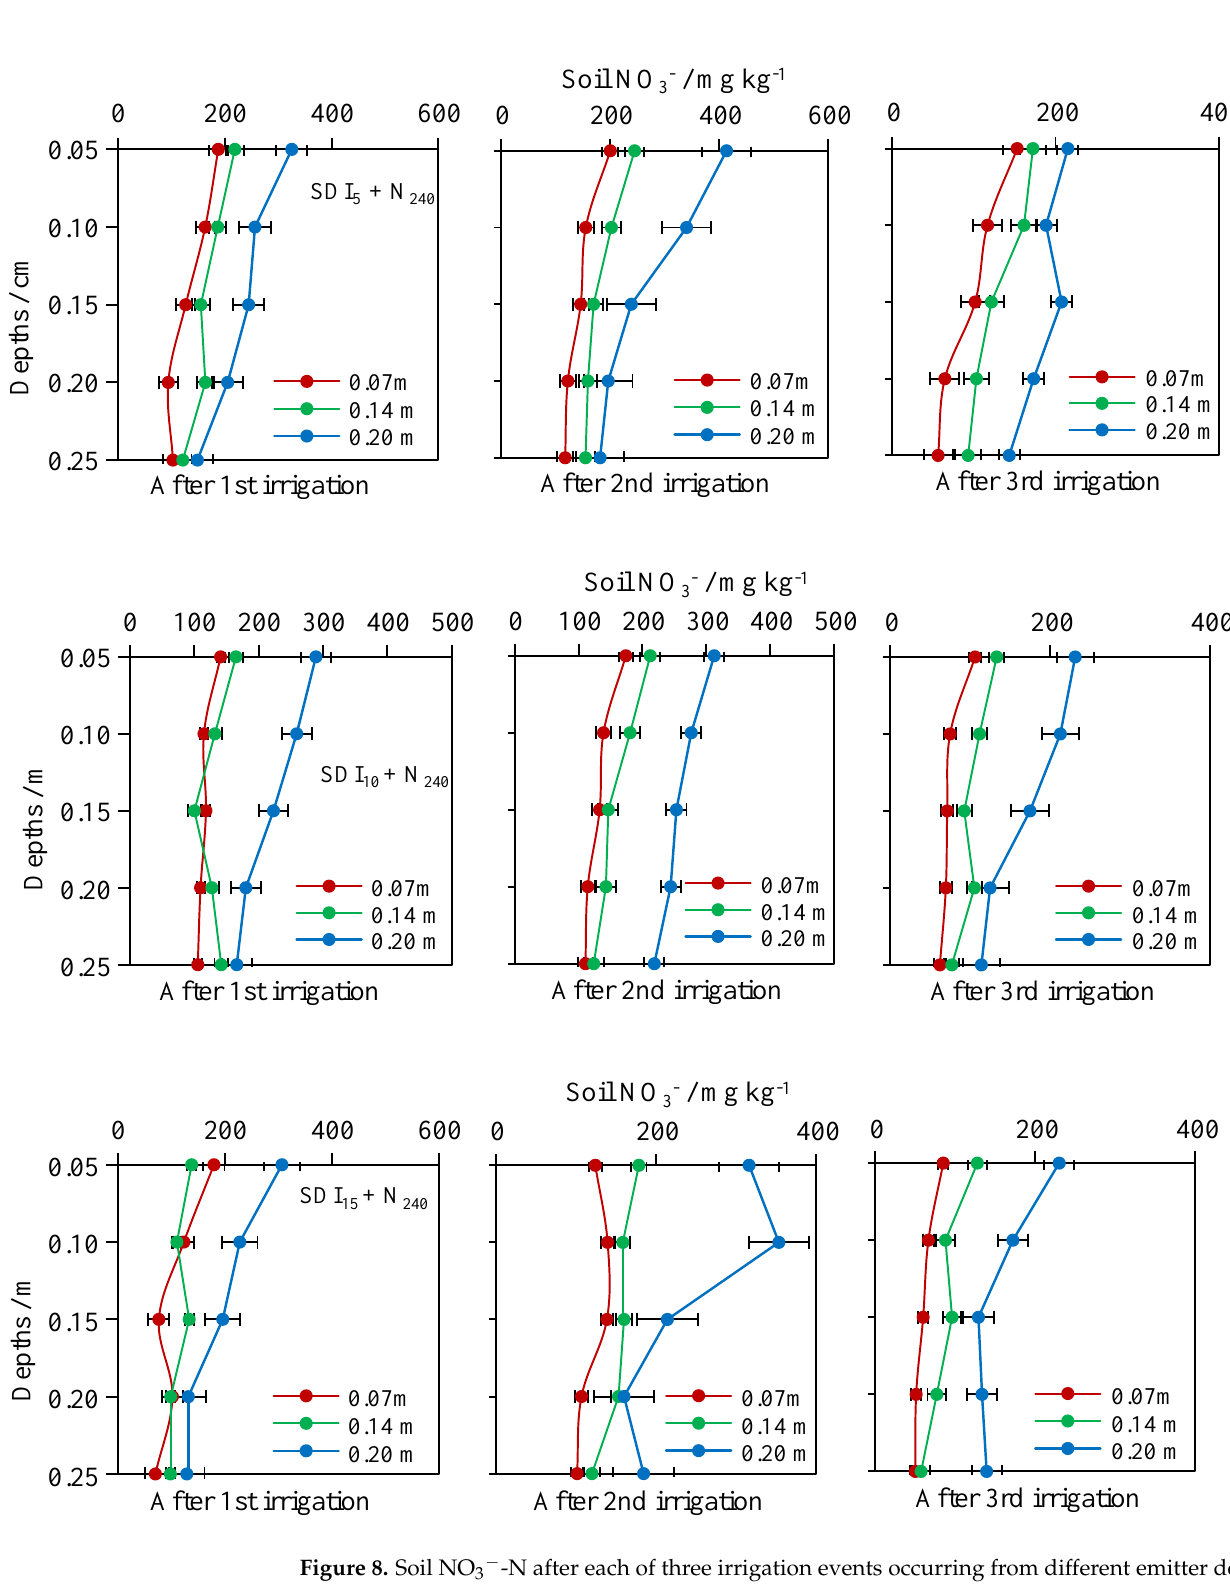
Figure 8. Soil NO 3 − -N after each of three irrigation events occurring from different emitter depths under the 240 kg N ha − 1 fertilization rate. Error bars represent standard error.